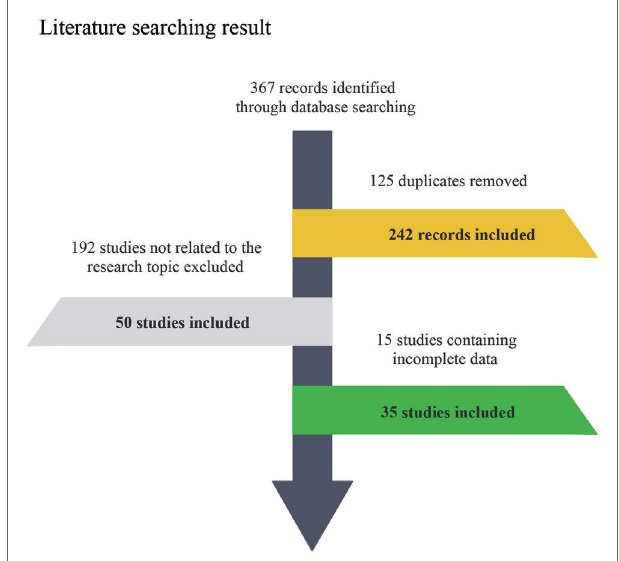
FigURe 1 | Flow diagram of included and excluded